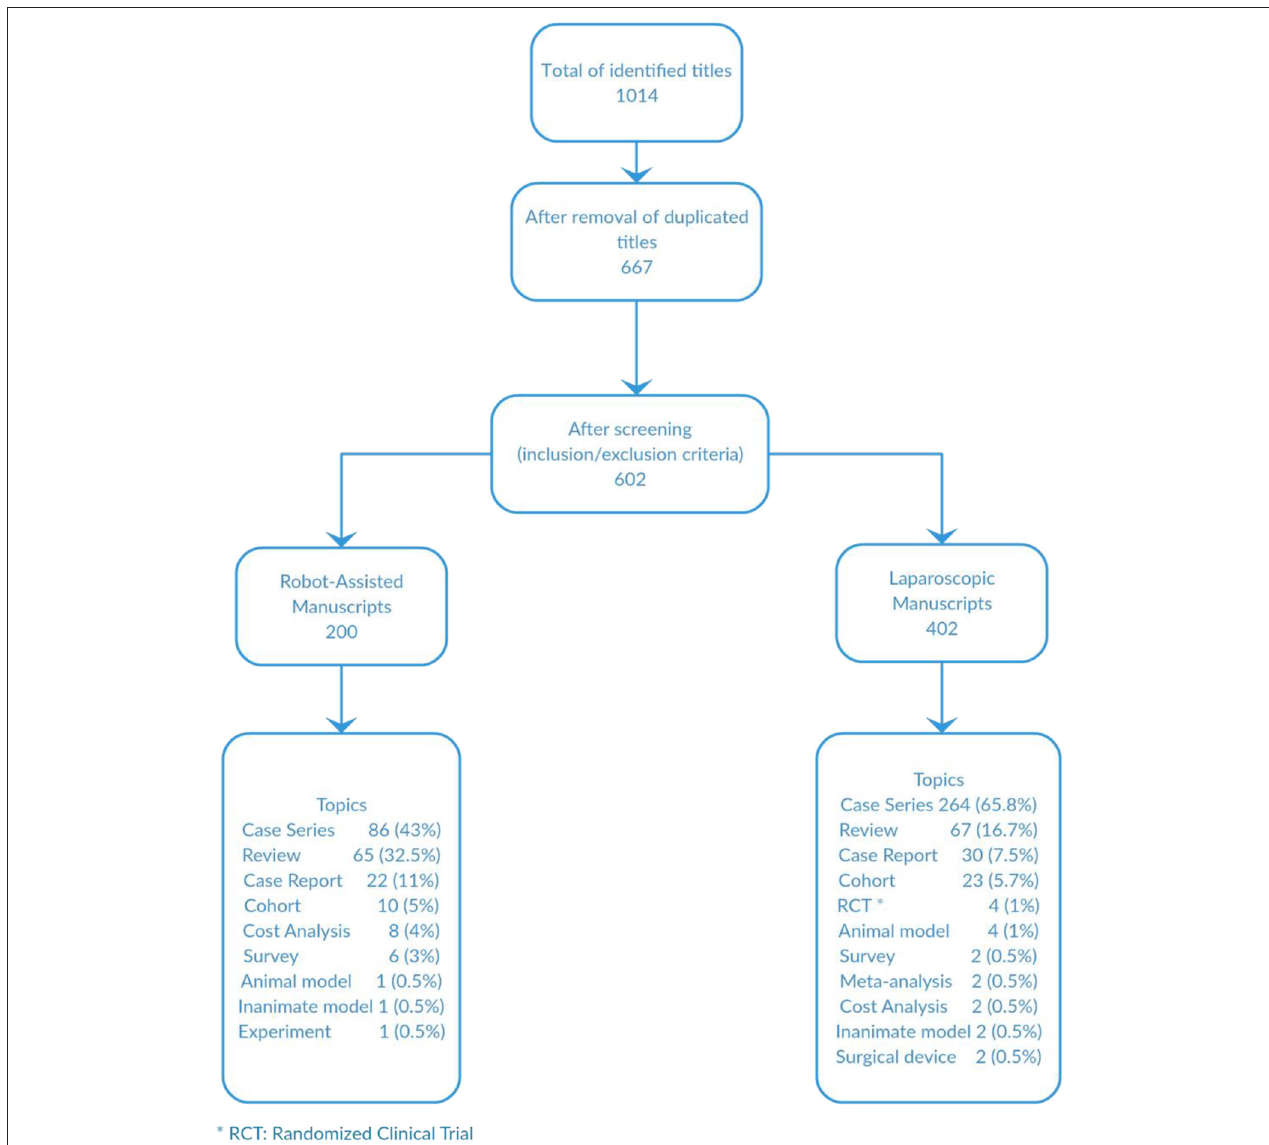
FIGURE 1 | Manuscript selection and distribution of types of